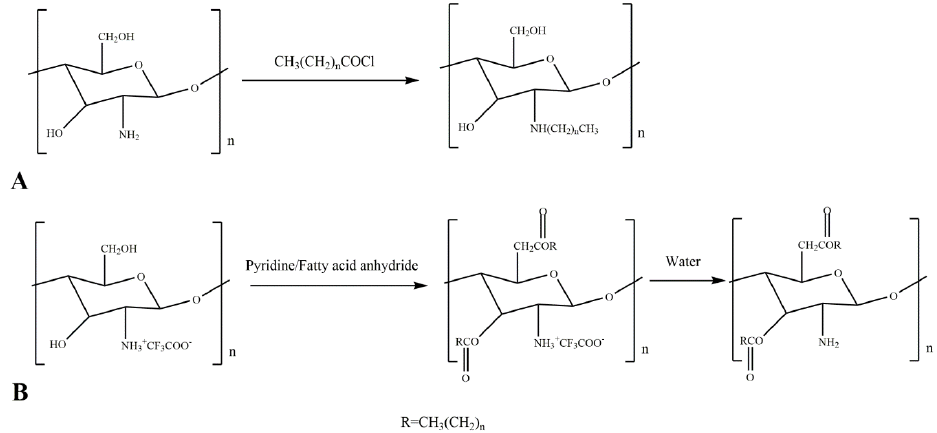
Figure 2. Reaction equations for acylated chitosan derivatives. ( A ) N-acylated chitosan; ( B ) O-acylated chitosan.